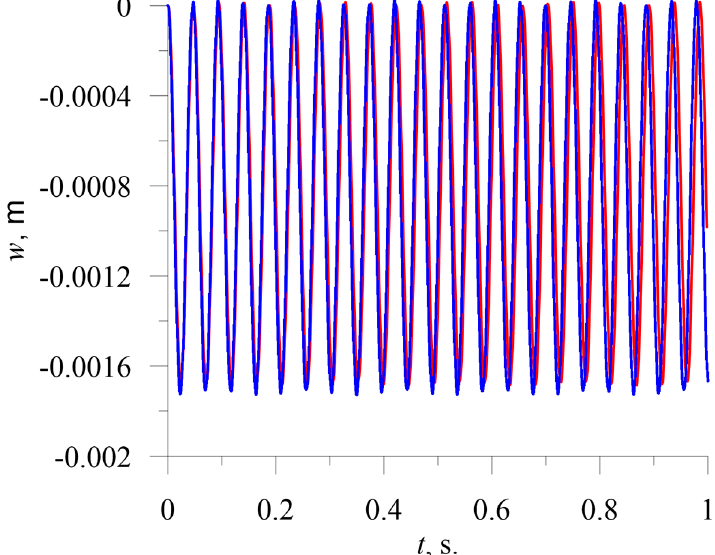
Figure 5. Time–history diagram of response of tip of beam subjected to uniformly distributed step load with p 0 = 100 N/m. Blue indicates presented model, red indicates MSC Nastran.